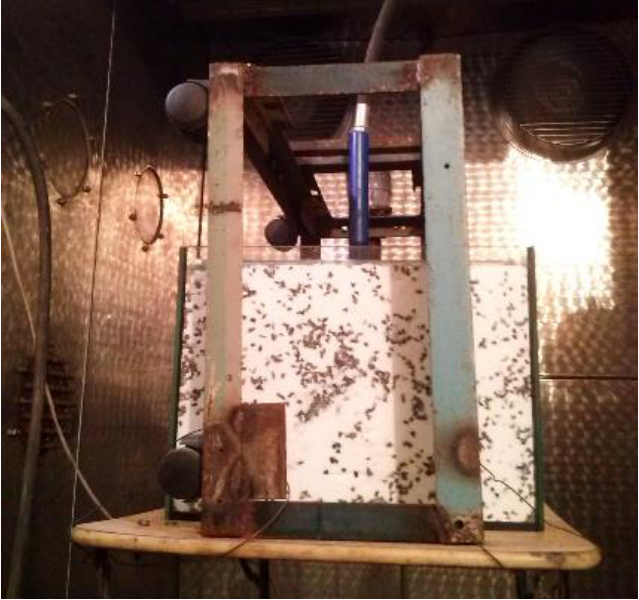
Figure 5. The tank used for modeling gas hydrate deposits and studying the gas hydrate dissocia- tion zone.